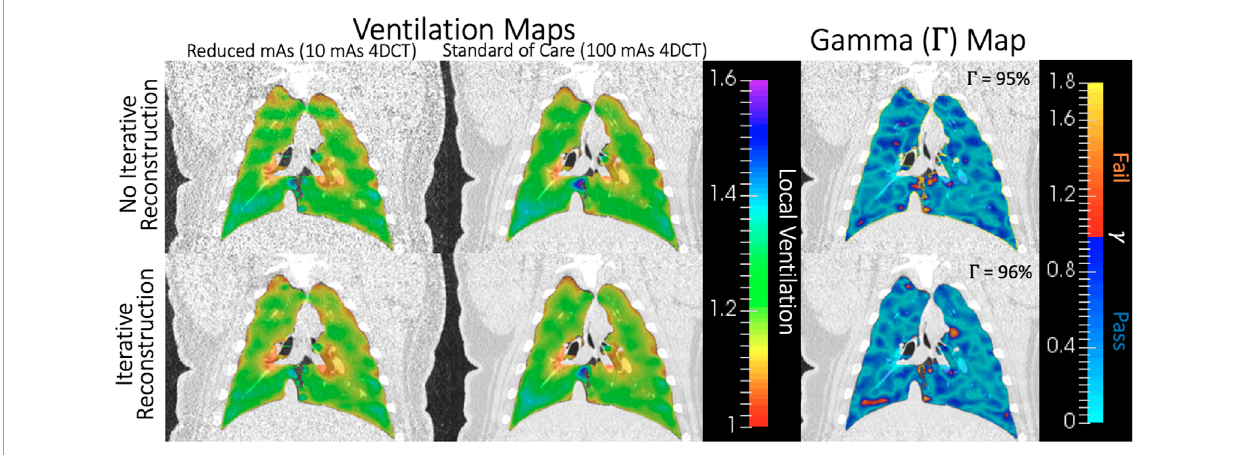
FIGURE 7 For one subject on one scan date, Jacobian values for all four CT-ventilation maps (10 and 100 mAs with and without IR) are shown in the two leftmost columns. On the right, gamma maps are shown for comparing the first two columns without (top) and with (bottom) IR applied. Blue-shaded voxels passed the Γ analysis, which was 95%–96 % of the lung volume in this example.